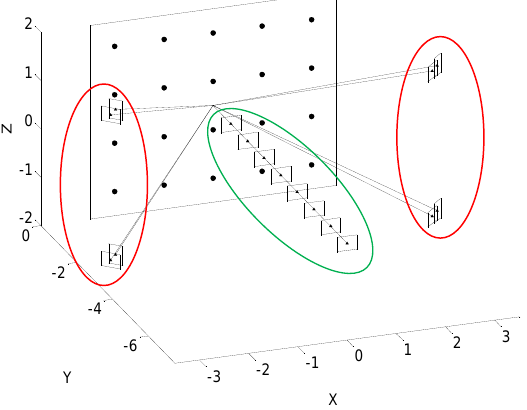
Figure 3. One-step integrated range camera calibration. Simultaneous calibration from x and y observations in the convergent image (red) and x, y and  observations in the normal images